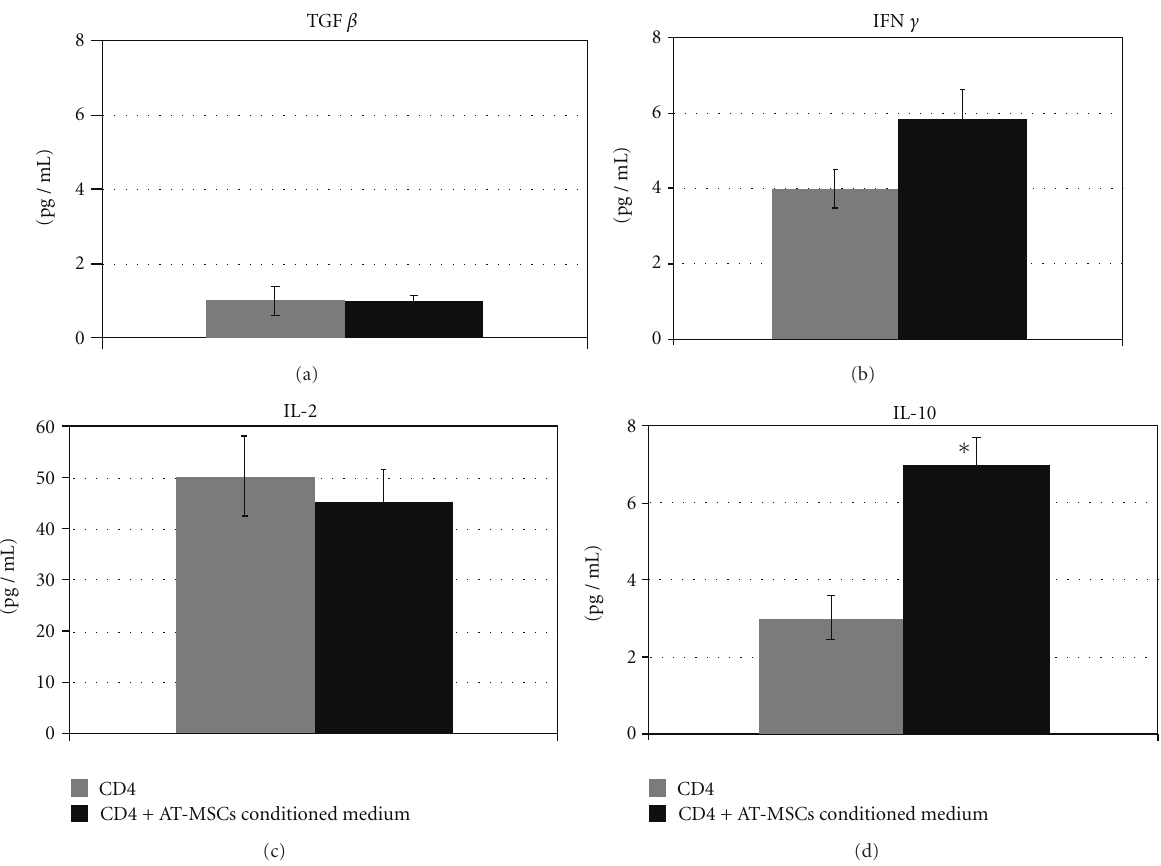
Figure 2: Cytokine secretion by CD4+ T lymphocytes cultured in AT-MSCs conditioned medium or control DMEM medium. Cultivation of CD4+ T cells in AT-MSCs conditioned medium did not induce changes in the secretion of TGF β (a), IFN γ (b), or IL-2 (c). In contrast the secretion of IL-10 was statistically significantly upregulated ( ∗ P < 0 . 05) in the presence of AT-MSCs conditioned medium compared with the control (d). Mean values ± SD of 12 independent experiments with cells from di ff erent donors are